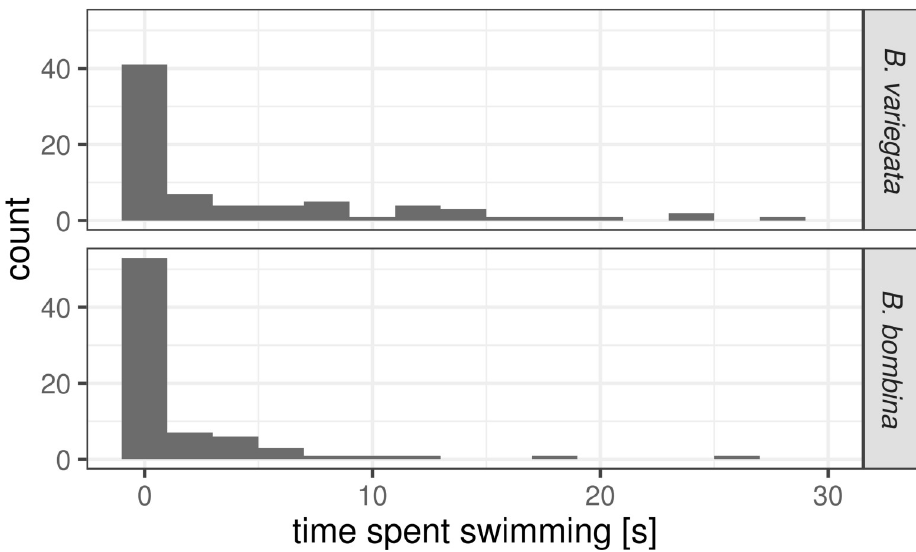
Fig 6. Distribution of the time spent swimming by taxon. Each observation interval lasted for 30 s. Number of intervals: 75 and 74 for B . variegata and B . bombina , respectively.